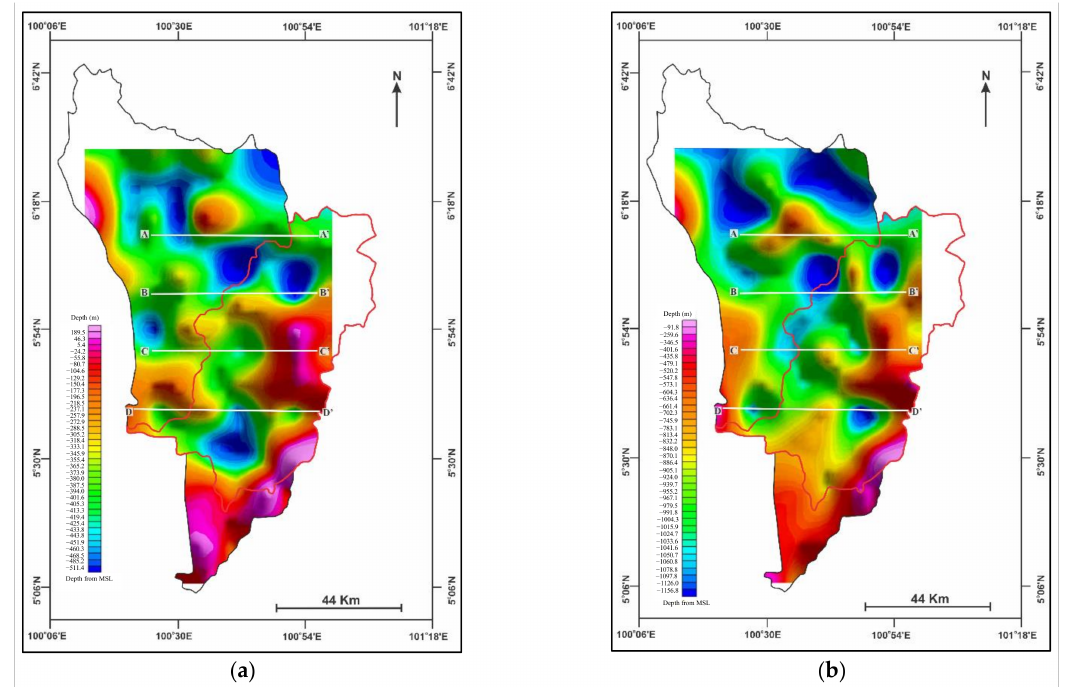
Figure 12. ( a ) Depth to shallow source map; ( b ) Depth to deep source